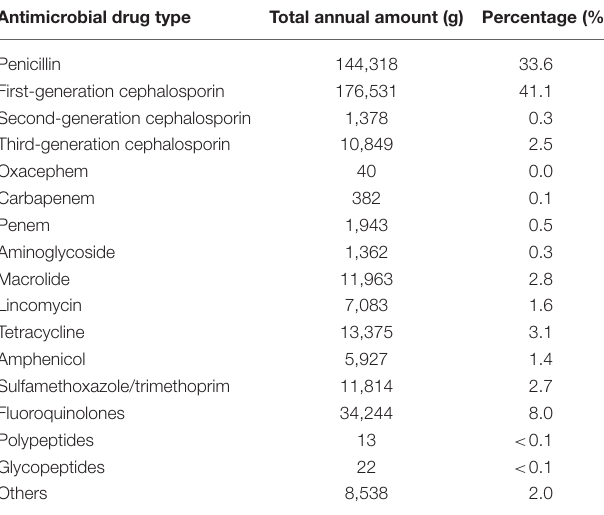
TABLE 4 | Total annual amount used (in grams) at the studied clinics categorized by antimicrobial drug type, and the percentage of the total drugs used. Antimicrobial drug type Total annual amount (g) Percentage